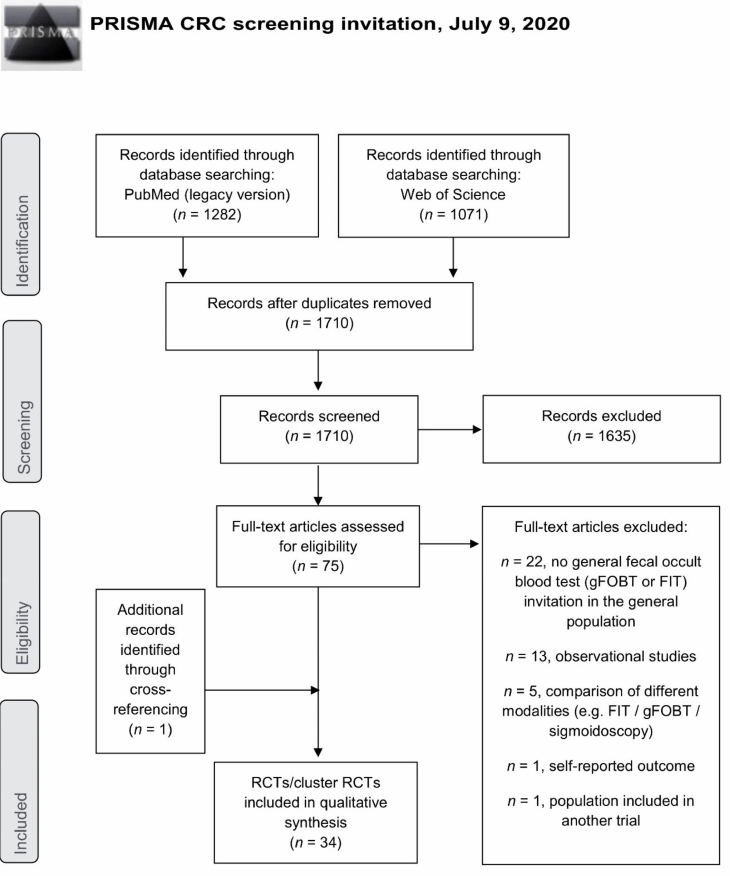
Figure 1. PRISMA flow diagram. CRC = colorectal cancer; FIT = fecal immunochemical test; gFOBT = guaiac-based fecal occult blood test; RCT = randomized controlled